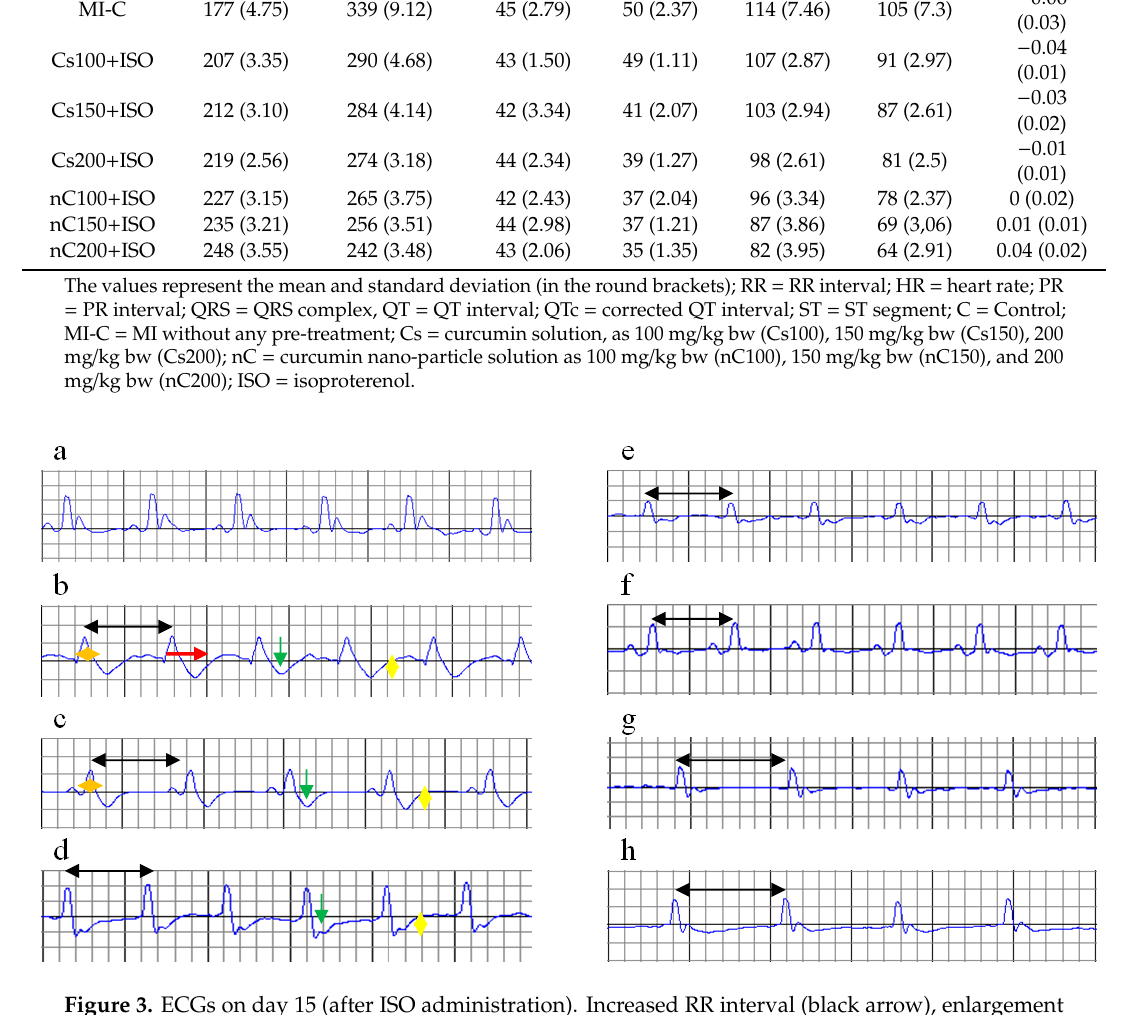
Figure 3. ECGs on day 15 (after ISO administration). Increased RR interval (black arrow), enlargement of the QRS complex (orange arrow), increased QT interval (red arrow), ST-segment depression (green arrow), T wave inversion (yellow arrow). ( a ) C = Control; ( b ) MI-C = myocardial infarction (MI) without any pre-treatment; ( c ) curcumin solution, as 100 mg/kg bw (Cs100), ( d ) curcumin solution, as 150 mg/kg bw (Cs150), ( e ) curcumin solution, as 200 mg/kg bw (Cs200); ( f ) curcumin nano-particle